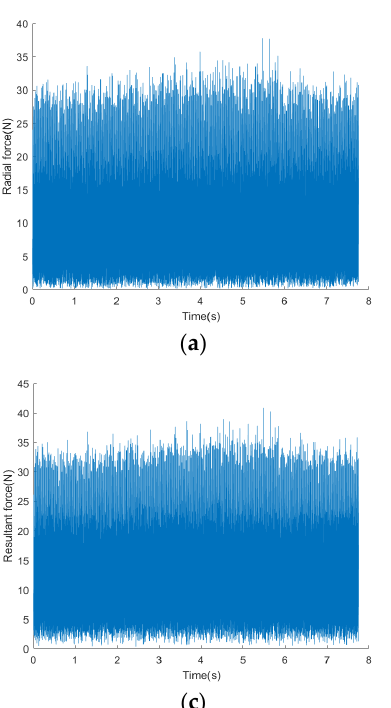
Figure 22. Cutting force: ( a ) F x of DACT; ( b ) F y of DACT; ( c ) F z of DACT; ( d ) F x of BEM; ( e ) F y of BEM; ( f ) F z of BEM.